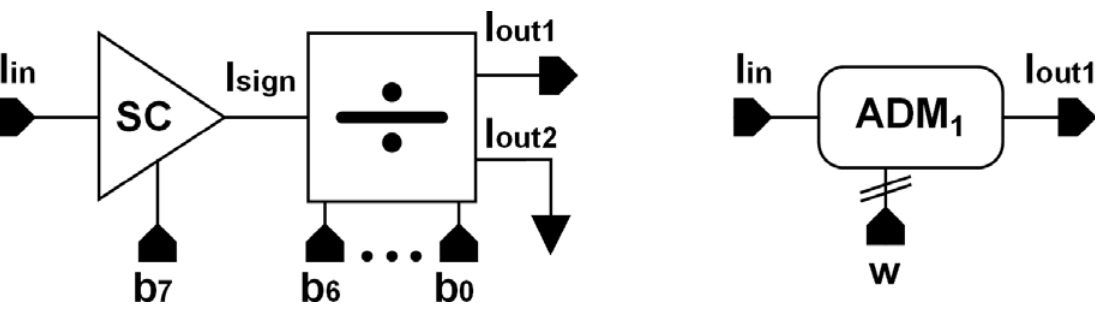
Figure 2. Four-quadrant analog-digital current